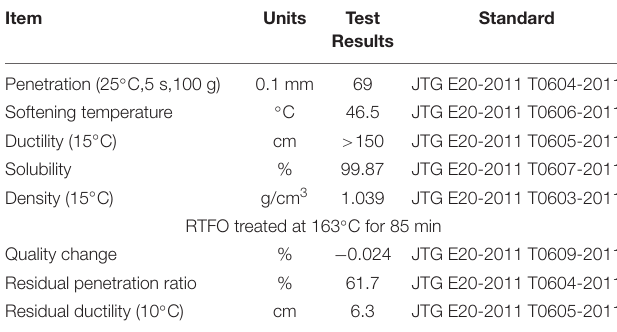
TABLE 1 | Properties of base asphalt binder.